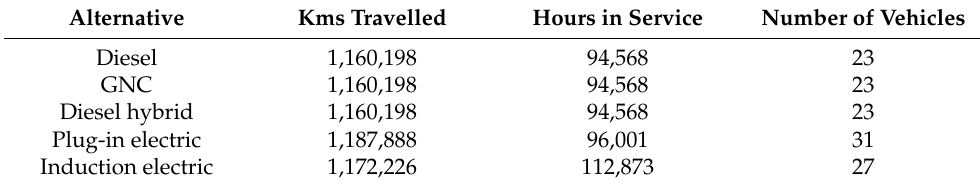
Table 1. Data on requirements by type of fuel.